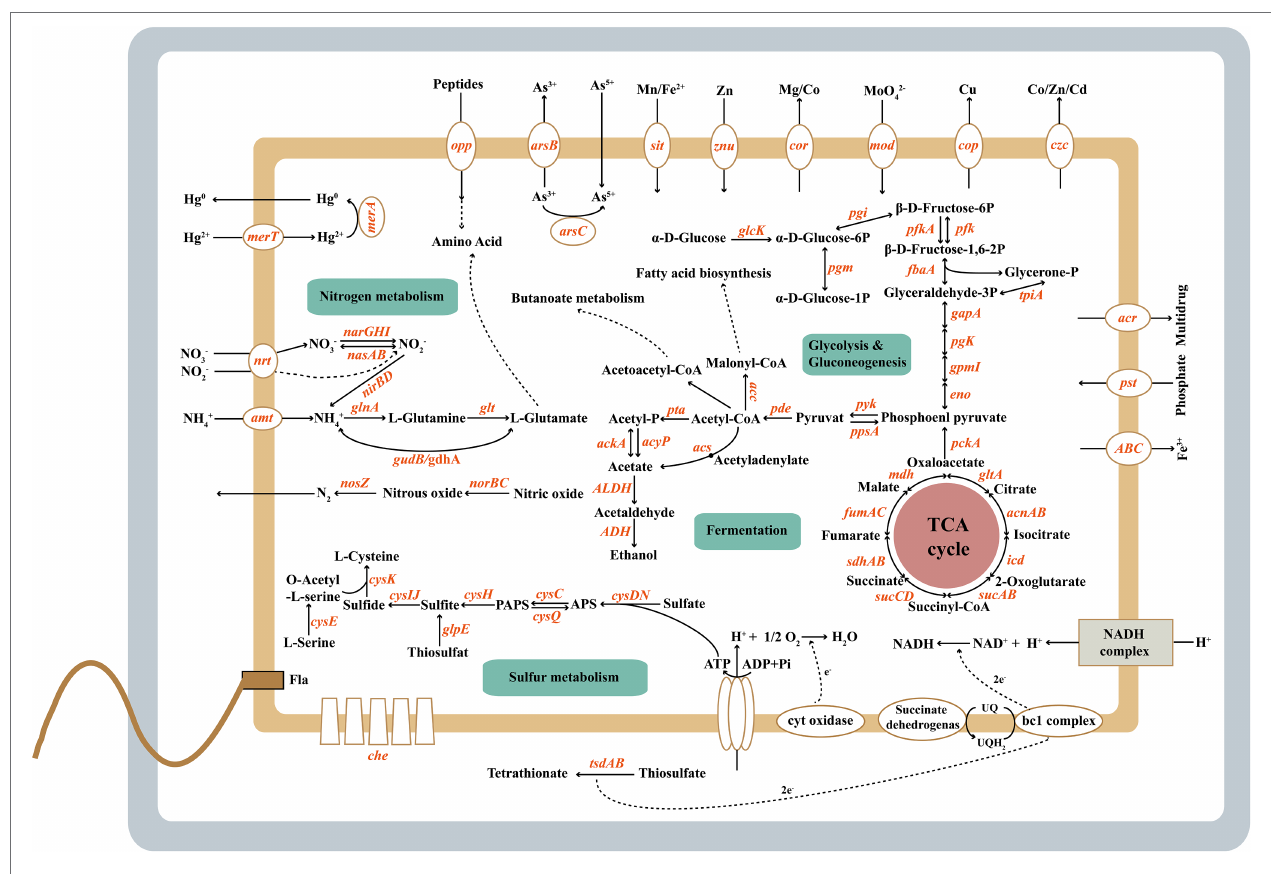
FIGURE 5 | The metabolic features of Halomonas titanicae